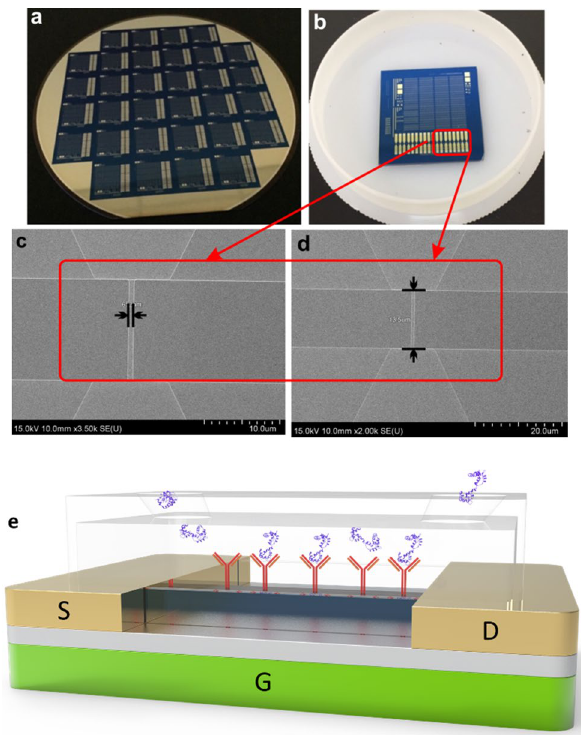
Figure 2. ( a , b ) The images of the fabricated SiNW-FET device. ( c , d ) showed the SEM images of the representative nanowire region with average length and width. ( e ) Schematic diagram of single SiNW-FET